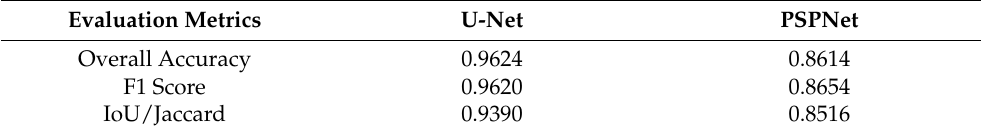
Table 5. Results of U-Net and PSPNet models.